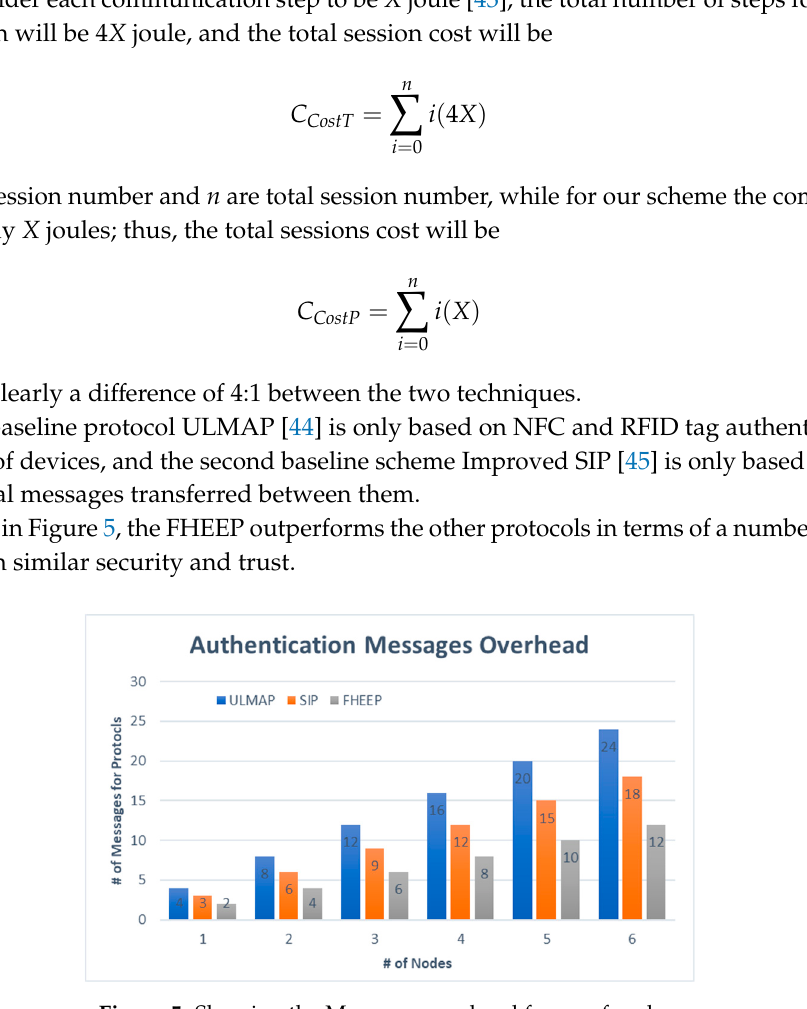
Figure 4. Showing the decreased communication cost between two nodes.